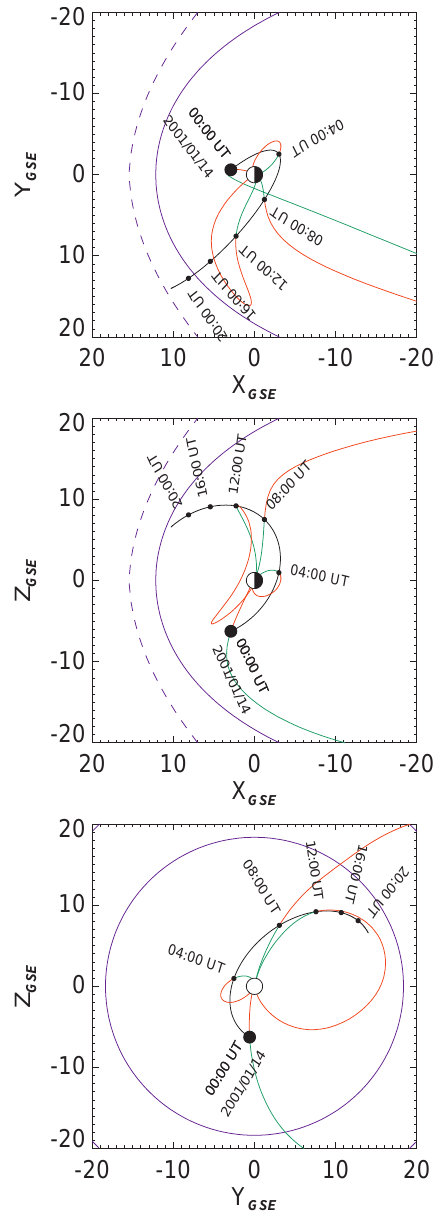
Fig. 2. The Cluster orbit in Geocentric Solar Ecliptic ( X GSE , Y GSE , Z GSE ) coordinates (in black) along with the mapped field lines that give ionospheric footprints, such as that shown in Fig. 1. (a) , (b) and (c) are projections onto the ( X GSE , Y GSE ), ( X GSE , Z GSE ) and ( Y GSE , Z GSE ) planes and the solid and dashed blue lines show the model magnetopause and bow shock locations for Z GSE = 0, Y GSE = 0, and X GSE = 0, respectively, predicted using the mag- netopause model by Shue et al. (1997) and the bow shock model by Peredo et al. (1995). Traced field lines are shown from the space- craft locations at 04:00, 08:00 and 12:00UT. Field lines mapped to the local (northern) hemisphere are shown in green, and those mapped to the southern hemisphere are in